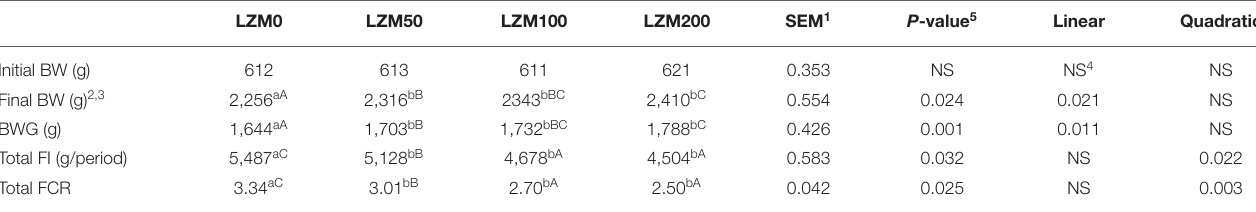
TABLE 2 | Effect of varying levels of chicken egg lysozyme (LZM) on the growth and feed efficiency of growing rabbits.